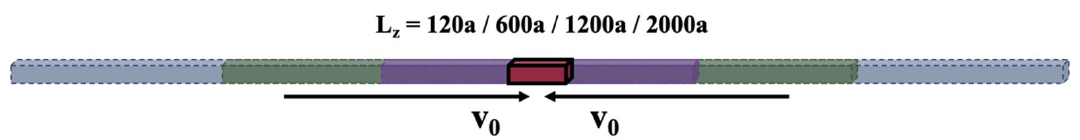
Figure 1. Initial configuration of the simulated sample with the preset void in the center. The compression process was generated by the impact between the two parts of the sample.